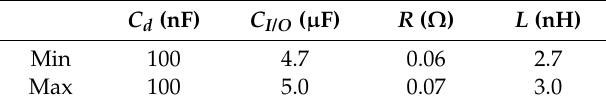
Table 3. Parameters for the